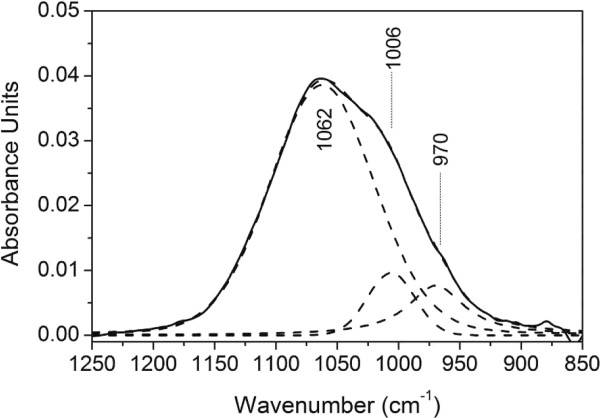
The infrared band of phosphate adsorbed ontoγ-Al2O3from an aqueous 0.5 mM phosphate solution at pH 9.0 after 20 minutes of adsorption. The fitted sub-bands resulted in a RMS error of 0.0004.